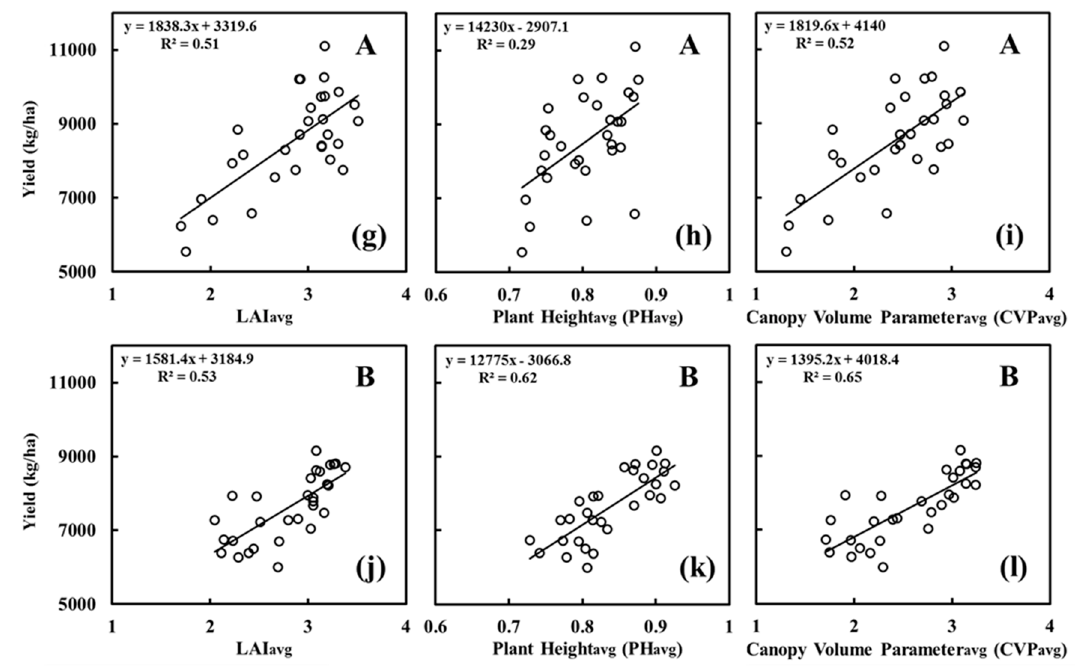
Figure 3. Relationships between canopy parameters and yield. ( a – c ) LAI HS , PH HS and CVP HS of the A varieties; ( d – f ) LAI HS , PH HS and CVP HS of the B varieties; ( g – i ) LAI avg , PH avg and CVP avg of the A varieties; and ( j – l ) LAI avg , PH avg and CVP avg of the B varieties.